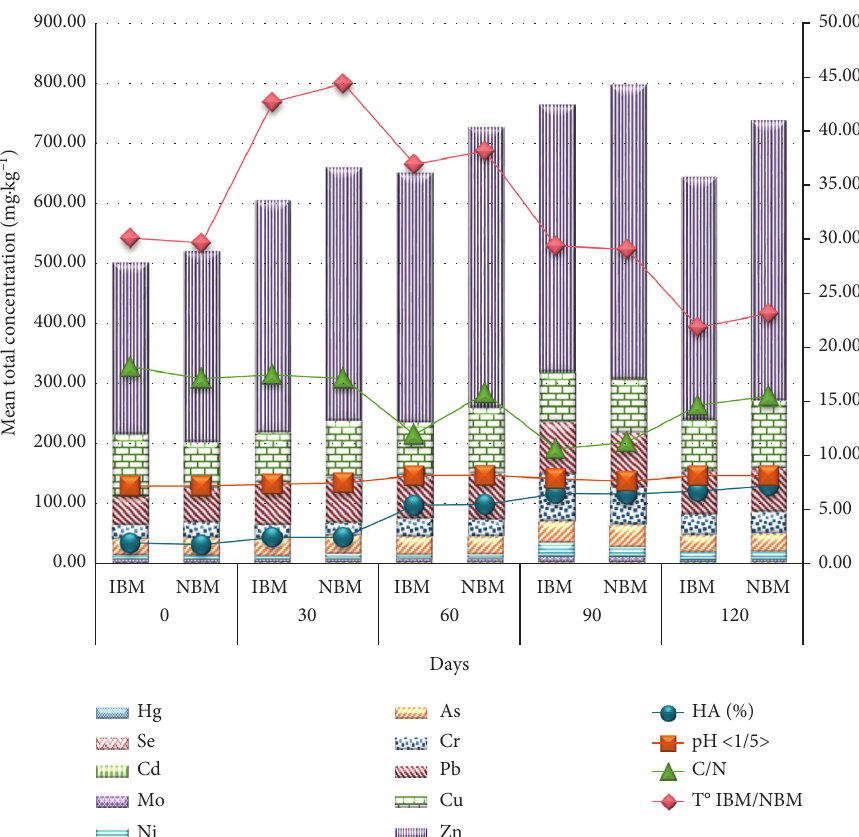
Figure 7: Total concentration of heavy metals and trace elements of interest and physicochemical variables (HA, pH, C/N ratio, and T ° ratios) during the composting of cattle manure and tree litter in piles inoculated with beneficial microorganisms (IBM) and in non- inoculated (NBM)